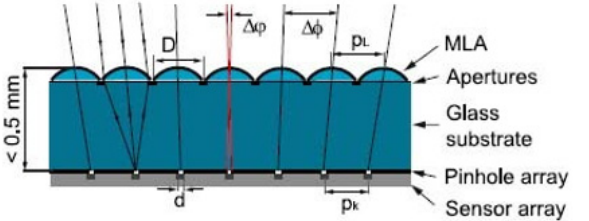
Figure 4. The schematic diagram of the APCO system. Adapted with permission from [33] © The Optical Society.